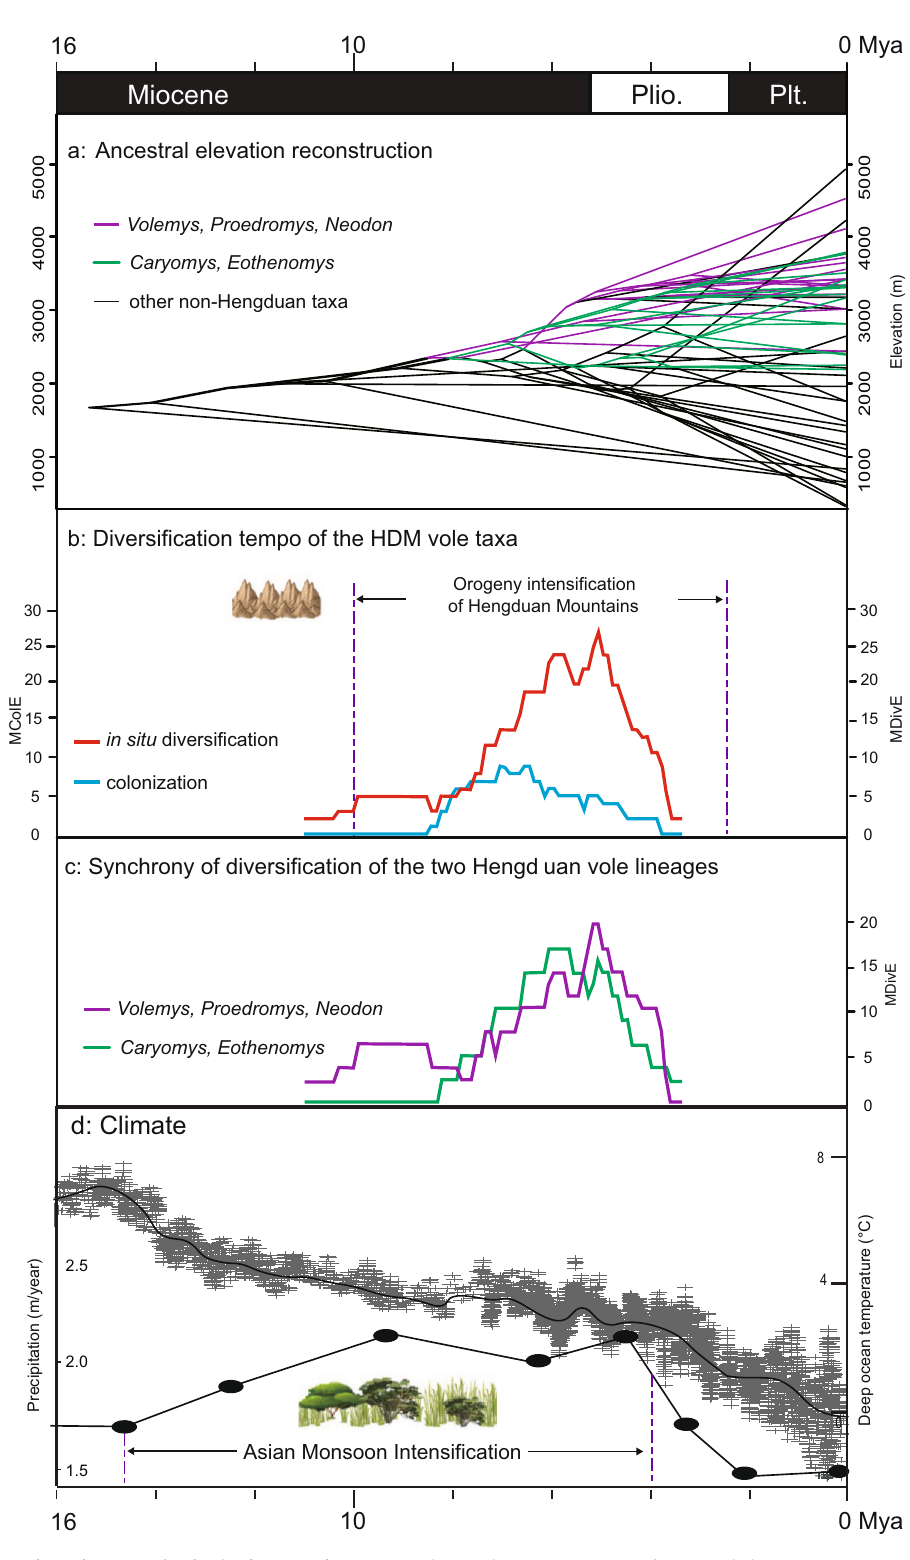
Fig. 4 Diversi fi cation mode and tempo of voles in the Hengduan Mountains. a The reconstruction of ancestral elevation suggests an evolutionary trend of high-elevation adaptation in HDM vole species (green and purple branches) relative to vole species outside the HDM region (black branches). b In situ diversi fi cation and colonization rates of HDM voles over time (smoothed across 0.1 Ma windows). MDivE = maximal number of observed in situ diversi fi cation events per 0.1 Ma. MColE = maximal number of observed colonization events per 0.1 Ma. c The in situ diversi fi cation rates of western HDM voles ( Volemys , Proedromys , and Neodon ) and eastern HDM voles ( Caryomys and Eothenomys ) are synchronous over time. d Global temperature trends and monsoon conditions (indicated by annual precipitation) from the Miocene to the present (modi fi ed from Ding et al. 7